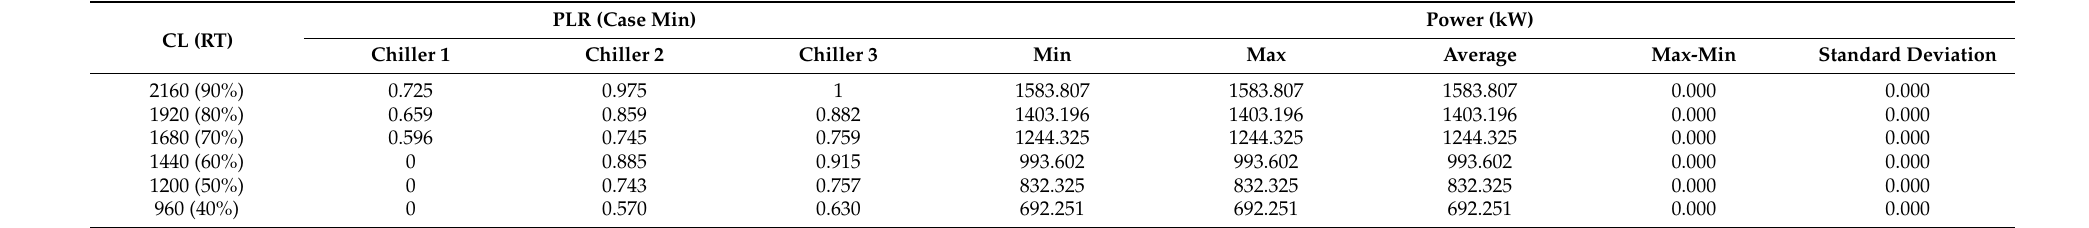
Table 11. Power Consumption of chillers in case 3 operated by TPSO